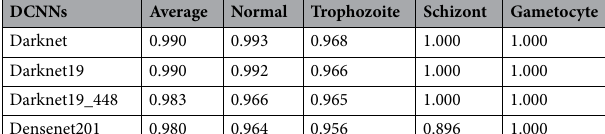
Table 5. Model-wise comparison and multiclass-wise comparison based on precision from one-class versus total.